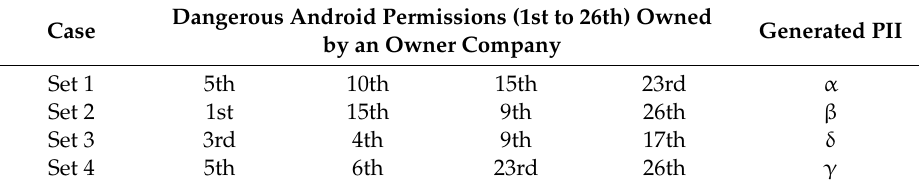
Table 3. Dangerous Android permissions set generating PII.